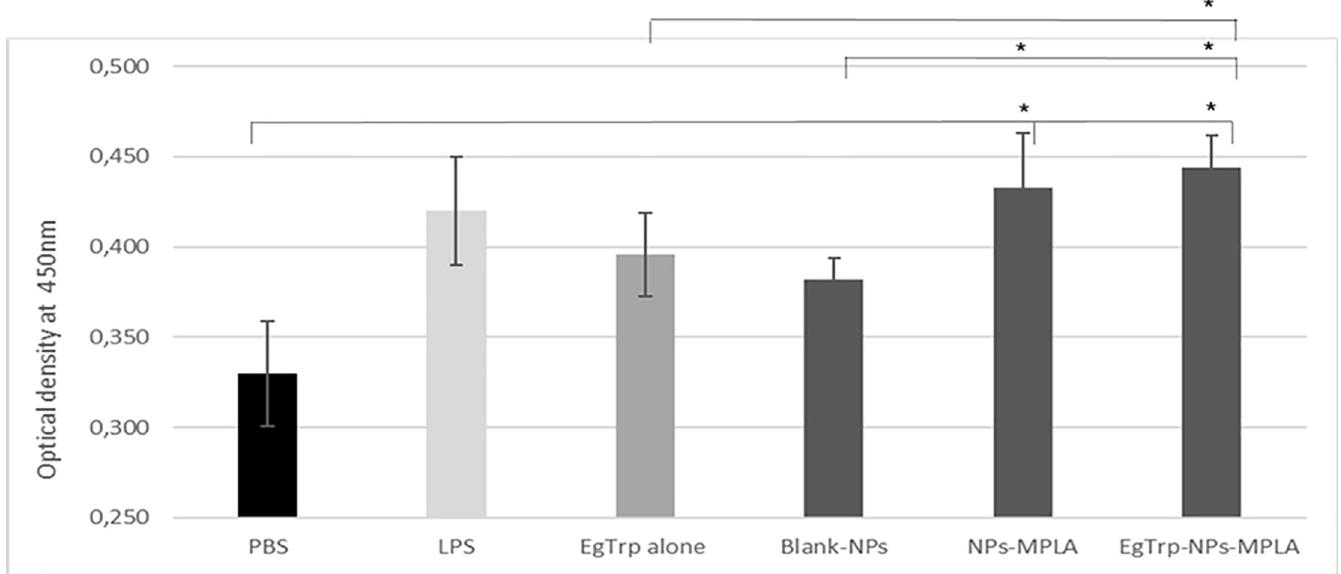
PLOS ONE | https://doi.org/10.1371/journal.pone.0229121 February 26,